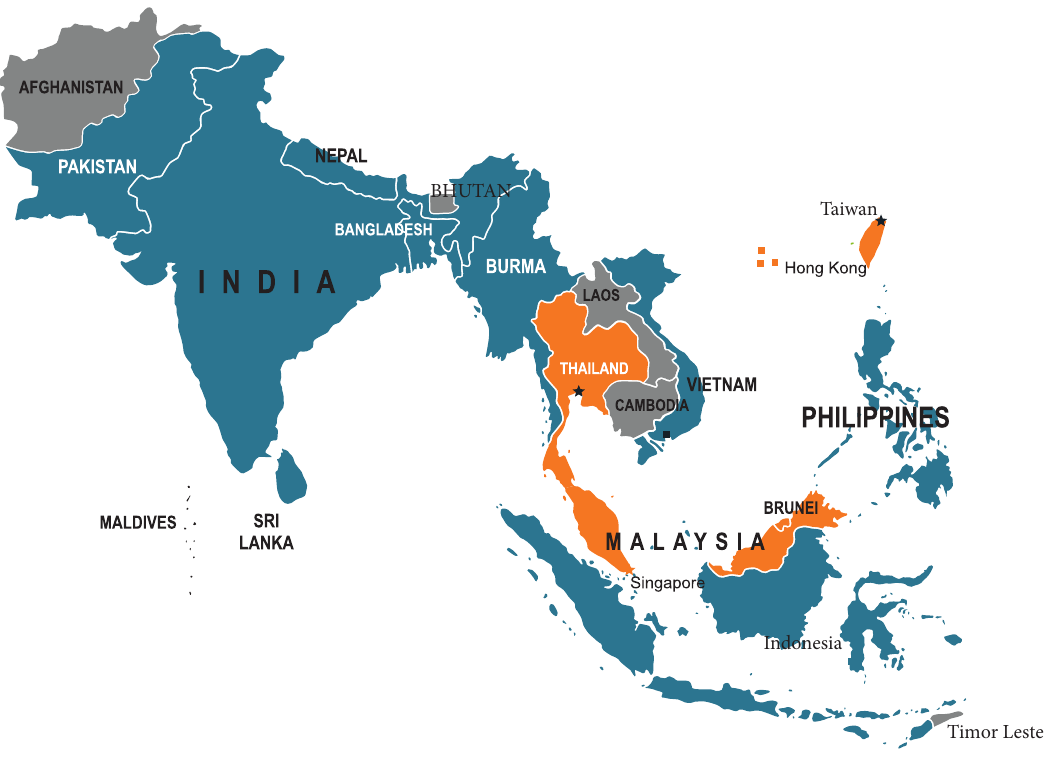
Figure 2: South Asia and Southeast Asia regional depiction based on